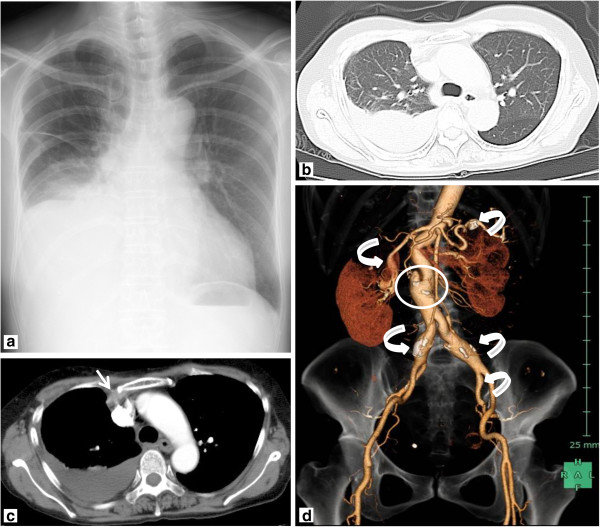
Chest and abdominal imaging findings. (a) Plain chest radiograph: pleural effusion was found in the right hemithorax. (b) Chest computed tomography: right pleural effusions were detected in the lung window. (c) In the mediastinal window, the right pleural effusion was 30 to 60 Hounsfield units; a low-density area (white arrow) was found around the right internal thoracic artery. (d) Abdominal computed tomography: saccular/fusiform aneurysms (white curved arrows) were found in the celiac artery, splenic artery, superior mesenteric artery, renal arteries and common iliac artery. Aortic dissection was found (white circle).